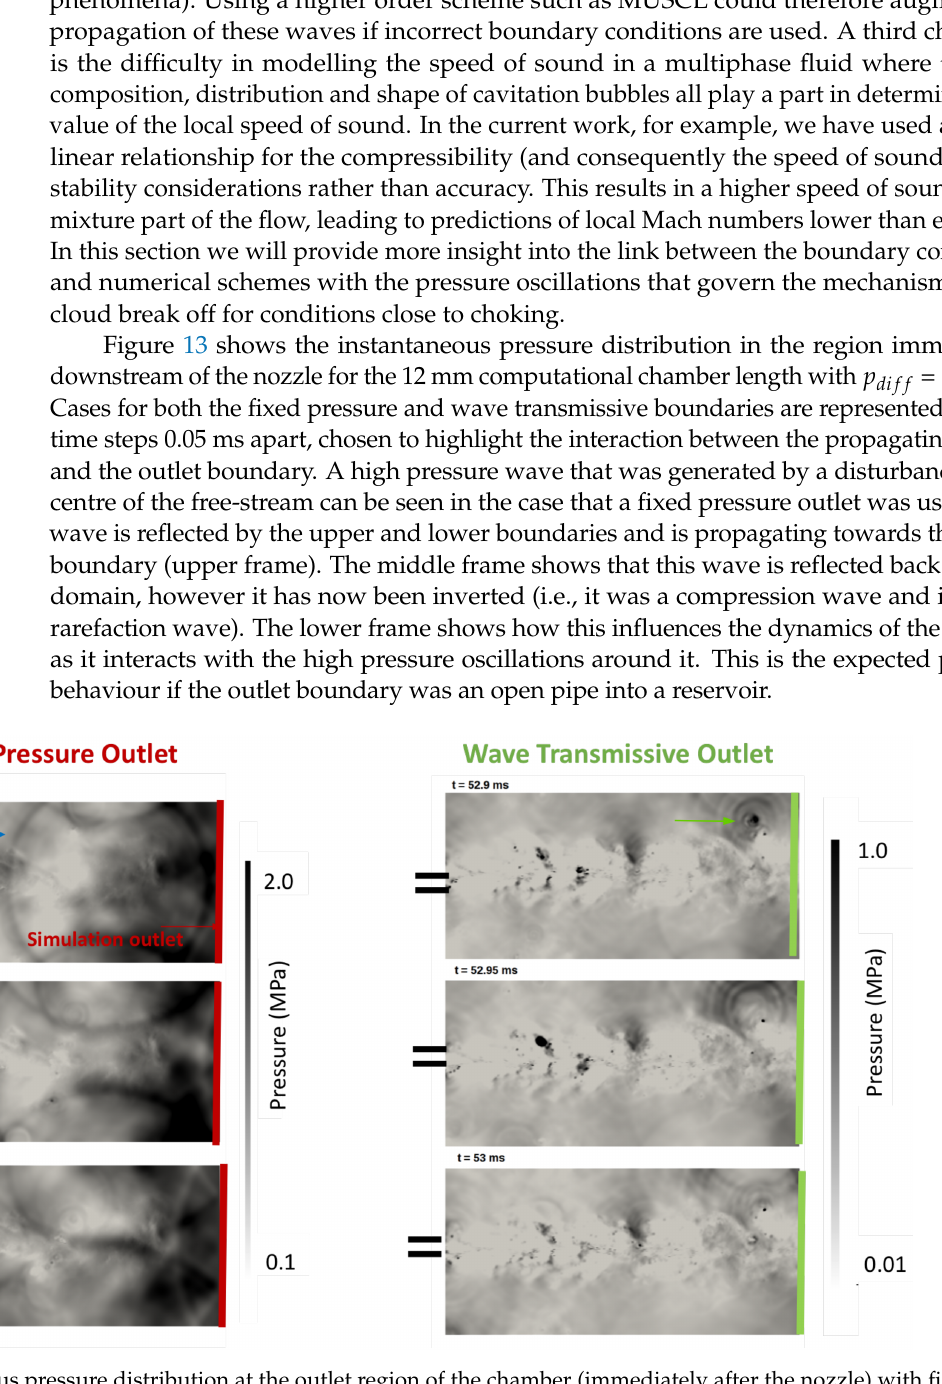
Figure 13. Instantaneous pressure distribution at the outlet region of the chamber (immediately after the nozzle) with fixed pressure outlet boundary condition ( left ), and wave transmissive outlet boundary condition ( right ), at three time steps 0.5 ms apart. For both cases the MUSCL differencing scheme has been used at p dif f = 8.5